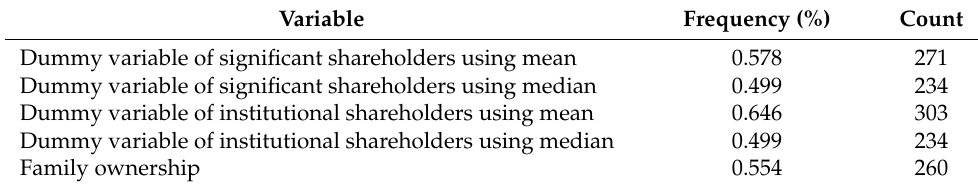
Table 3. Descriptive statistics ownership